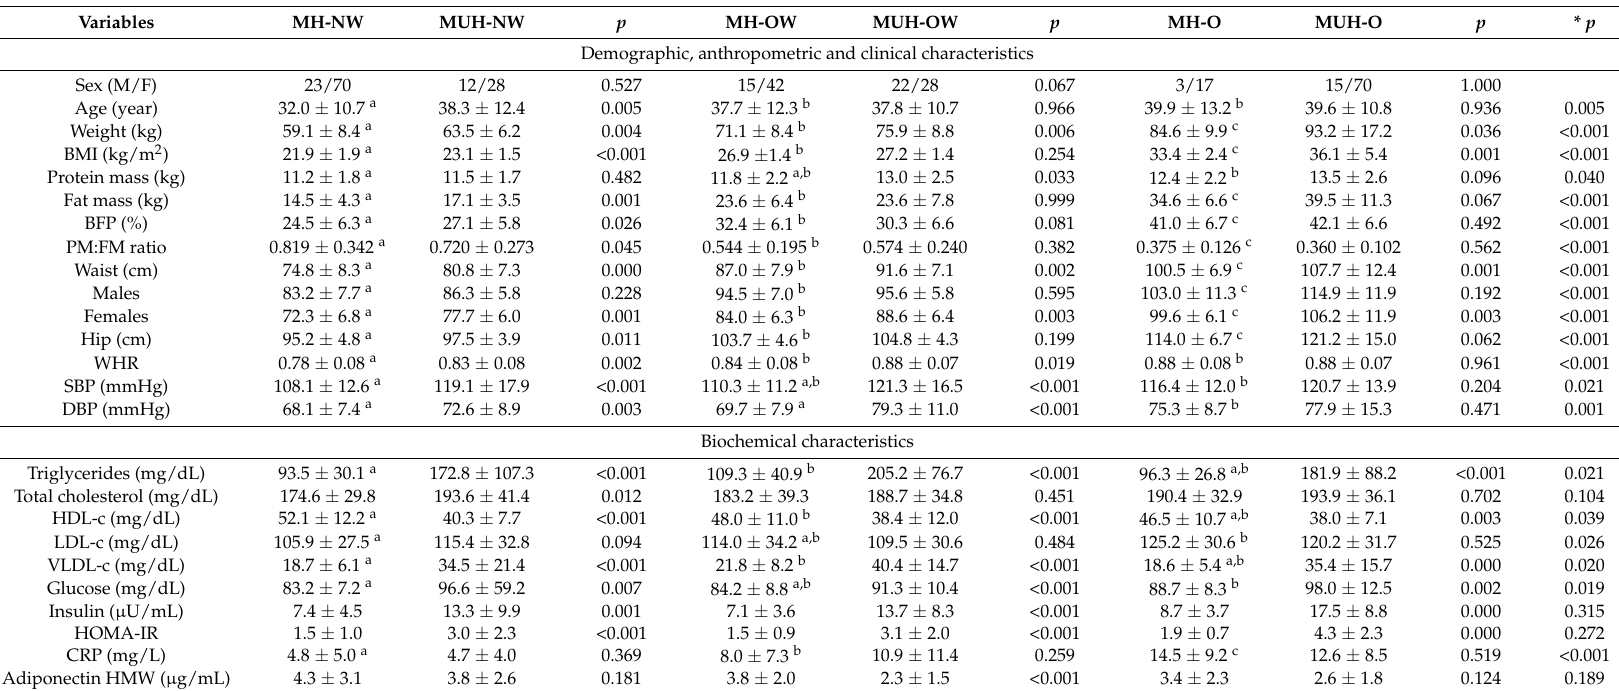
Table 1. Characteristics in metabolically healthy and metabolically unhealthy phenotypes according to BMI classification. Variables Demographic, anthropometric and clinical